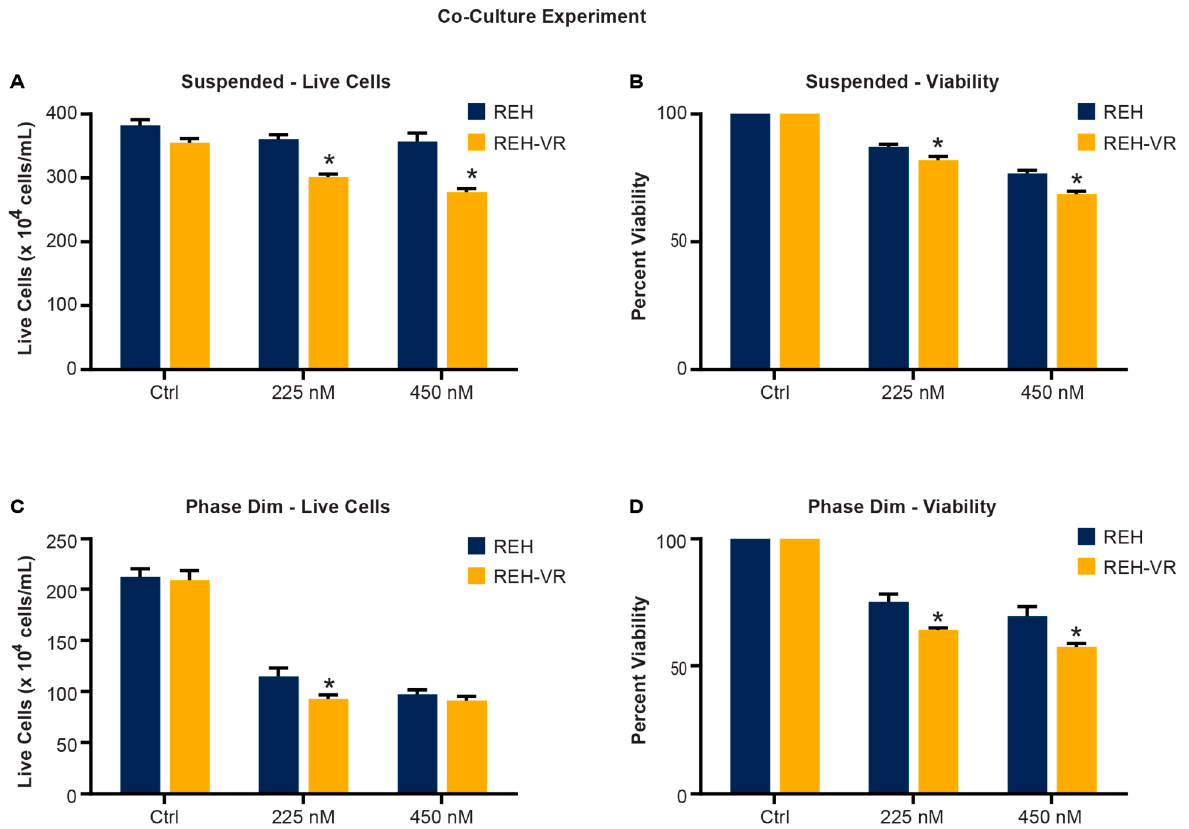
Figure 6. Co-culture model of leukemia cells with bone marrow stroma. Pitavastatin treatment reduced number of live cells in both the REH and REH-VR cells, at the concentrations tested. A Trypan Blue exclusion assay was used to analyze the suspended (S) ( A , B ) and phase dim (PD) ( C , D ) ALL cells from a co-culture following treatment with vehicle control (Ctrl) or pitavastatin (225 nM or 450 nM). Results are shown as the number of live cells ( A , C ) and the percent viable cells where the data have been normalized to the DMSO control viability set at 100% treatment ( B , D ). Each bar represents average ± S.D., where n = 3; * p < 0.05 denotes statistical significance when comparing REH and REH-VR for each treatment condition.